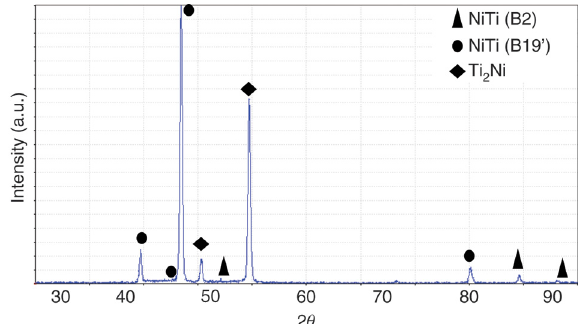
Figure 5: XRD patterns of powders after 60 h milling + 800 s